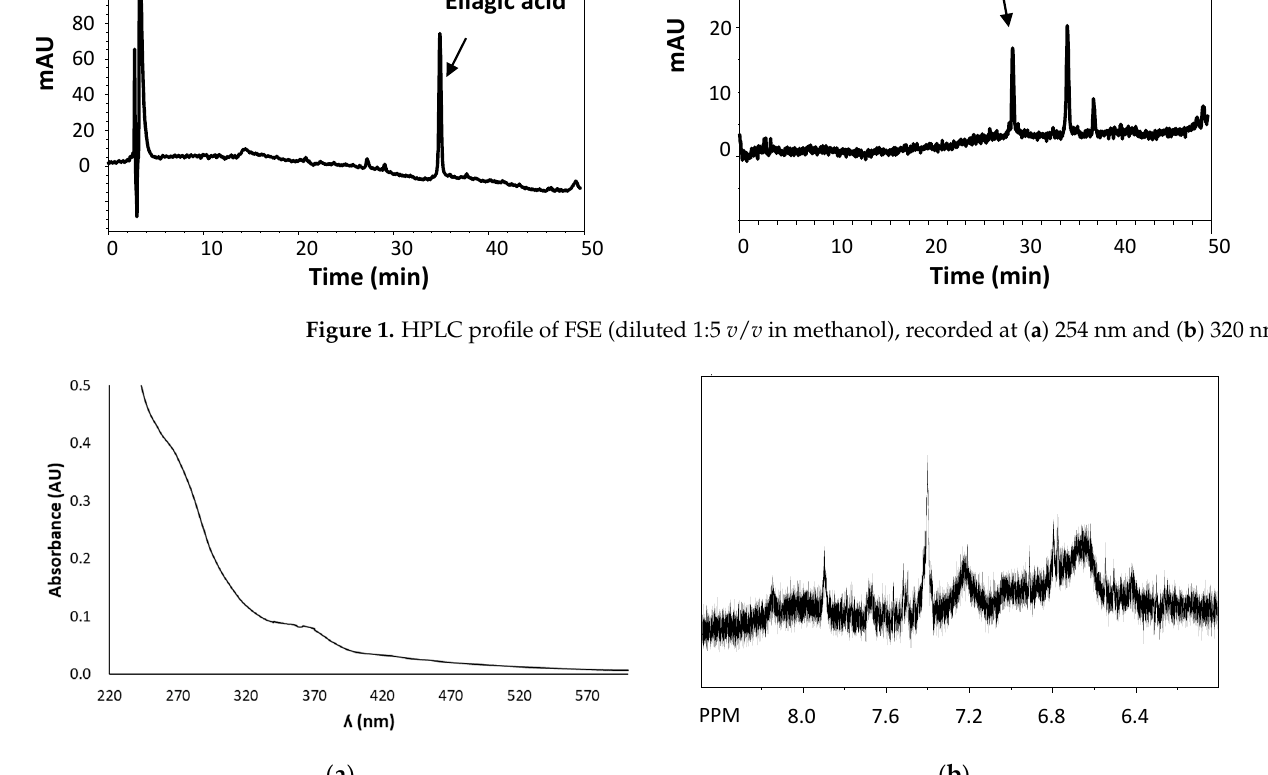
Figure 1. HPLC profile of FSE (diluted 1:5 v / v in methanol), recorded at ( a ) 254 nm and ( b ) 320 nm.